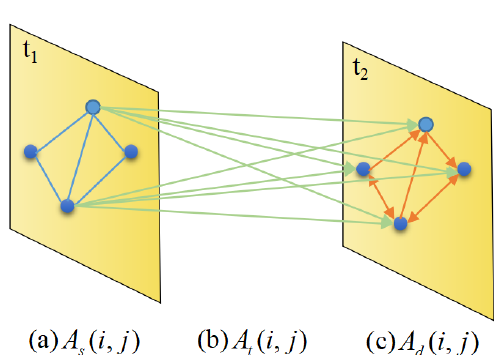
Figure 2. The three kinds of adjacency matrices that we construct. ( a ) A s indicates the shortest path distances between nodes, which are indicated as blue lines, ( b ) A d denotes the directions between different nodes, which are indicated as orange lines, and ( c ) A t represents the temporal correlations between nodes and their neighbors at adjacent moments, which are indicated as green